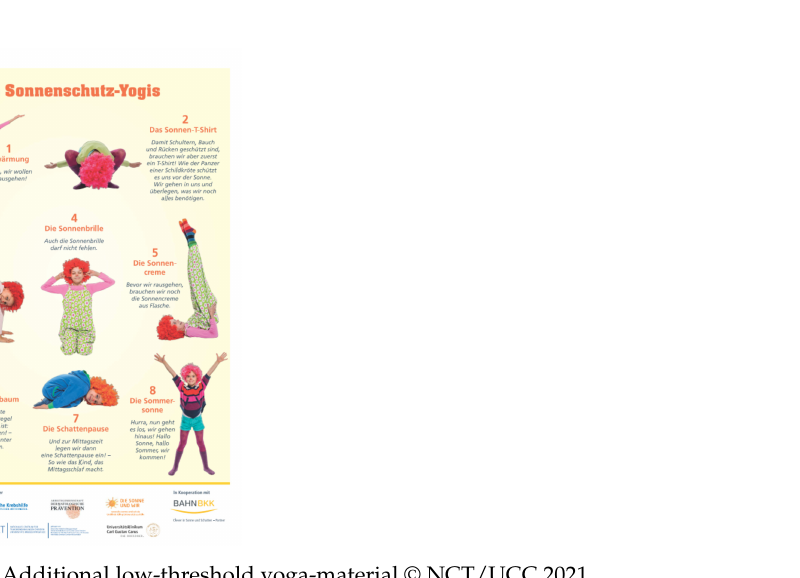
Figure 10. Additional low-threshold yoga-material © NCT/UCC